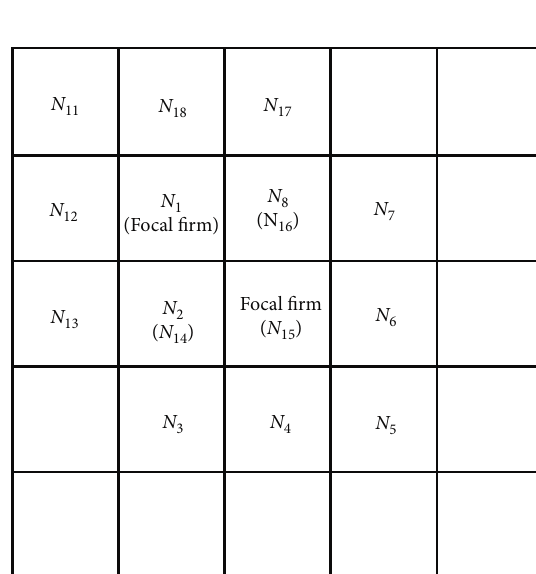
Figure 2: The changing role of the focal firm (buyer) and supplier in supply networks.